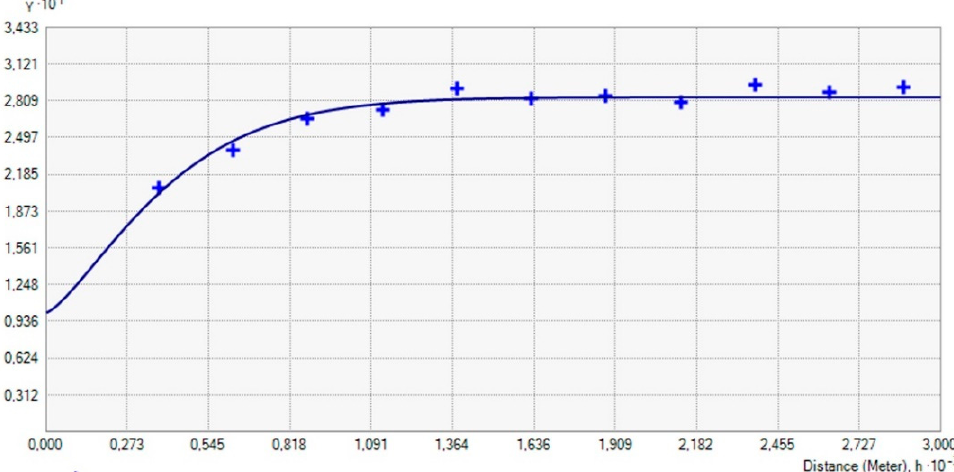
Figure A1. Experimental semivariogram (symbols) and models (line) for total concentration of Pb in the topsoil layer—PMNet.